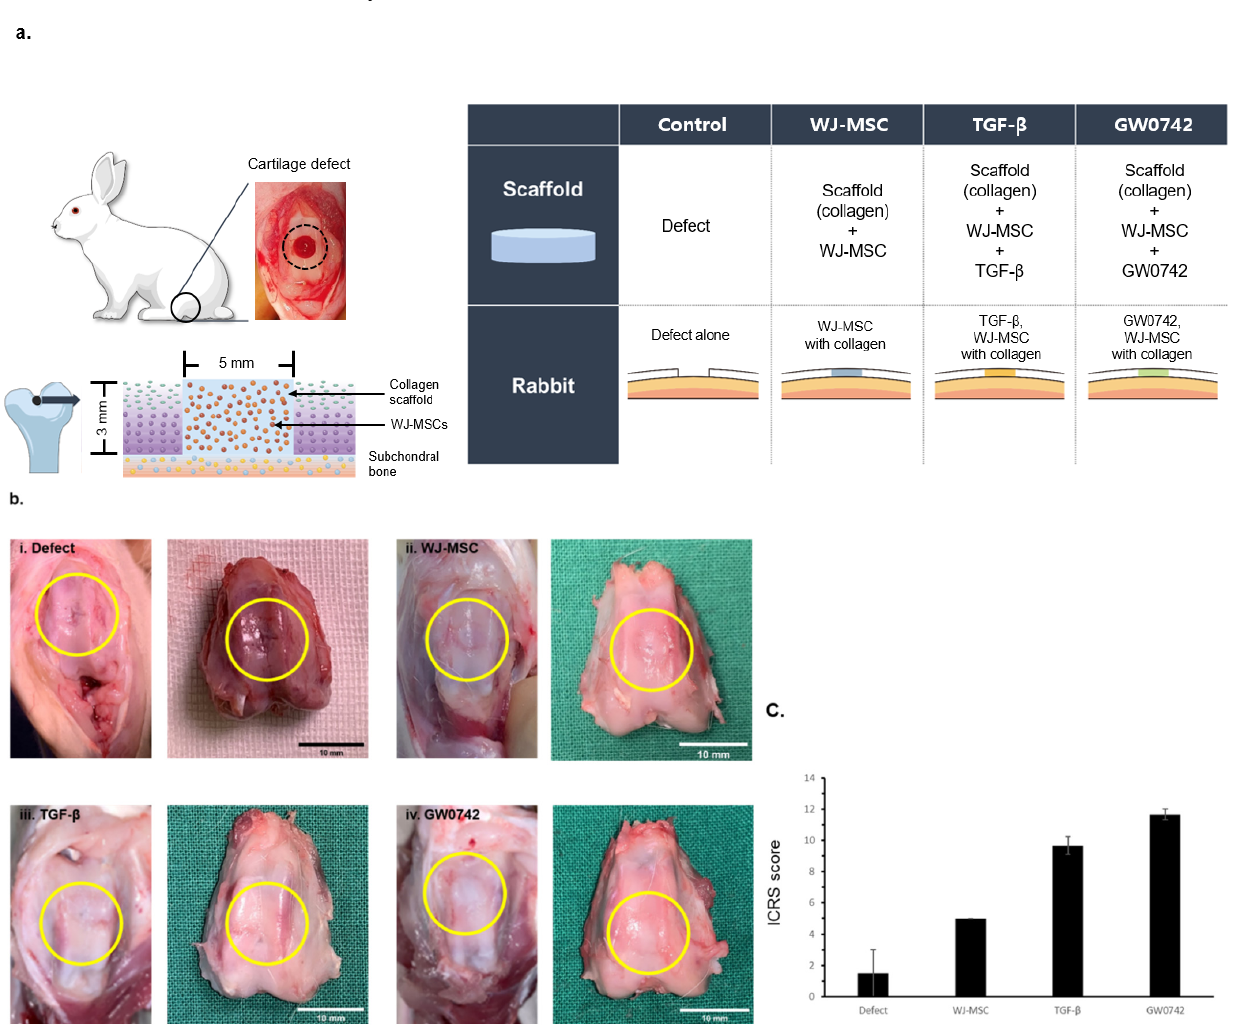
Figure 3. Gross observations of cartilage defect and regeneration by bio-printed scaffolds. ( a ) Scheme of cartilage defect generation and constitution of experimental group. Eight- to nine-week-old New Zealand white rabbits were divided into four groups (defect, scaffold, scaffold with TGF- β , and scaffold with GW0742). Cartilage defects with a 5 mm diameter and 3 mm depth at the trochlear groove and distal femur were generated by surgery. The same size of bio-printed scaffold was implanted at the defect. At 12 weeks of implantation, rabbits were sacrificed to analyze cartilage regeneration. ( b ) Macroscopic observations of repaired defects in the four groups at 12 weeks after implantation (i. defect, ii. WJ-MSCs, iii. TGF- β , iv. GW0742; the yellow circle indicates the site of the defect); scale bar: 10 mm. ( c ) Macroscopic ICRS scores and comparison of each group at 12 weeks after implantation. ICRS macroscopic scoring was of cartilage regeneration presence or absence on bio-printed scaffold. Data are represented as means ± SD.